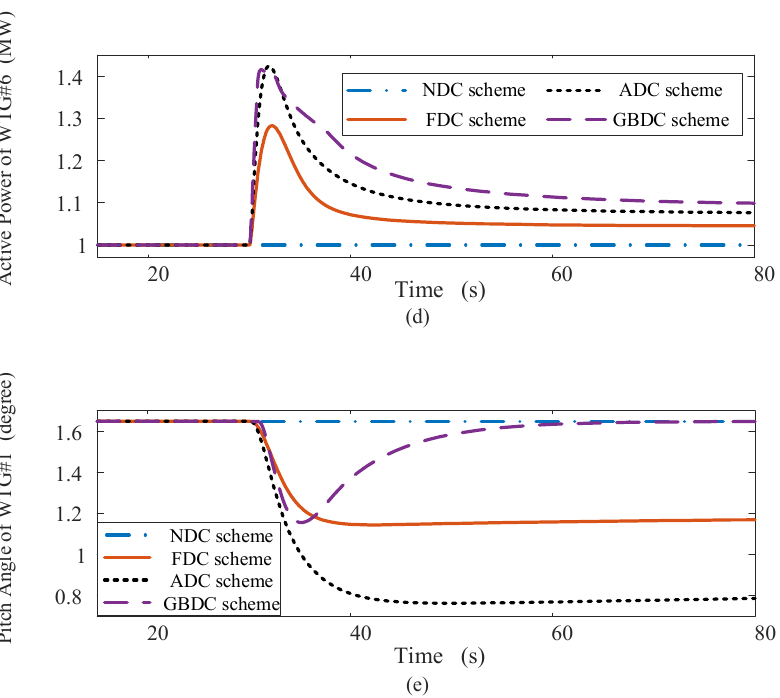
Figure 12. Simulation results of Case 2: ( a ) system frequency; ( b ) active power of WF; ( c ) active power of WTG#1; ( d ) active power of WTG#6; ( e ) pitch angle of WTG#1. The power and pitch angle curves of WTG#1 and WTG#6 are also presented in Figure 12. In the GBDC scheme, G 1 and G 2 are both appointed to participate in frequency regulation because of the large frequency deviation. The power increases in WTG#1 and WTG#6 are larger than those in the FDC scheme. In the ADC scheme, the peak powers of WTG#1 and WTG#6 are almost the same as those in the GBDC scheme. As the deviation decreases in the frequency regulation process, the GBDC scheme reduces the participating degree of G 2 . This is why the power of WTG#1 decreases faster than that in the ADC scheme. In the ADC scheme, the pitch angle of WTG#1 is reduced from 1.649 ◦ to 0.770 ◦ to capture more mechanical power. In the FDC scheme, the settled value is 1.160 ◦ . In the GBDC scheme, the pitch angle is reduced to 1.158 ◦ at t = 34.9 s and finally returns to 1.649 ◦